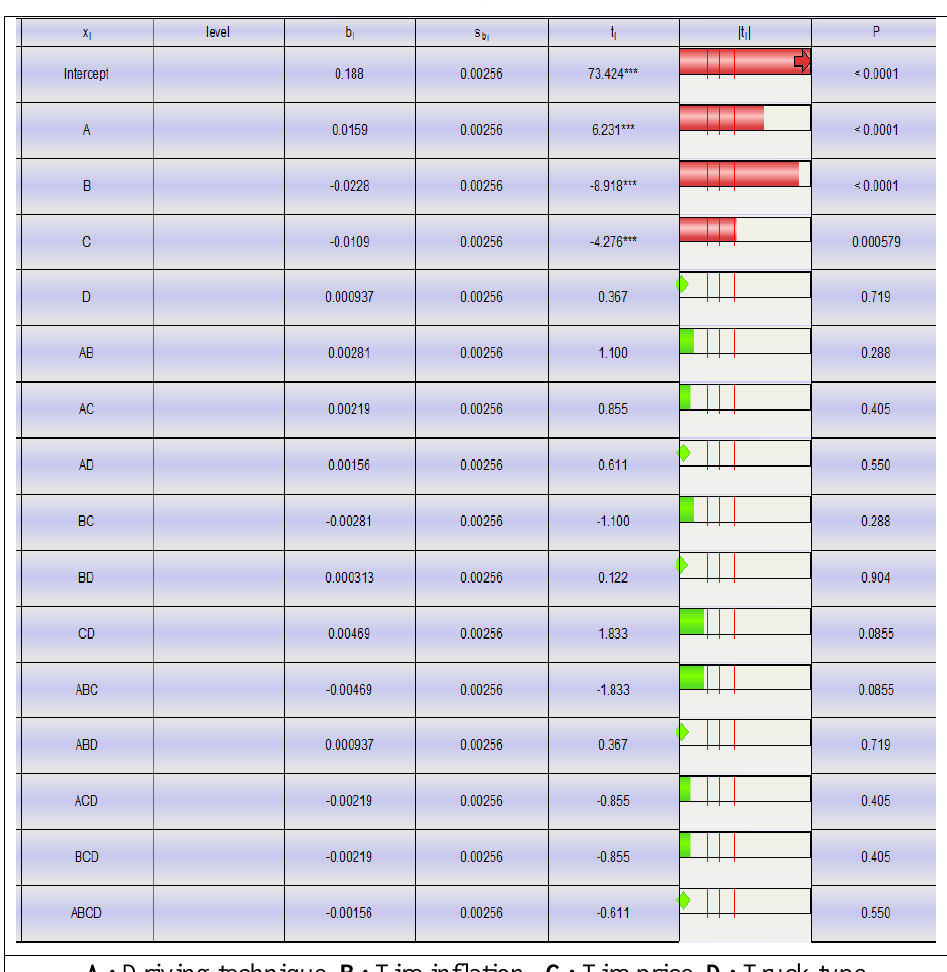
According to the results, three of four factors, such as A: Driving technique, B: tire inflation and C: tire price have statistically significant ( α =0,01) impact on depth of tires tread. On the other hand experiment didn’t revealed any statistically significant interaction between factors. The influence of factors on tire tread worn-out (mm) is presented by slope of the line in Figure 4. The steeper line means higher